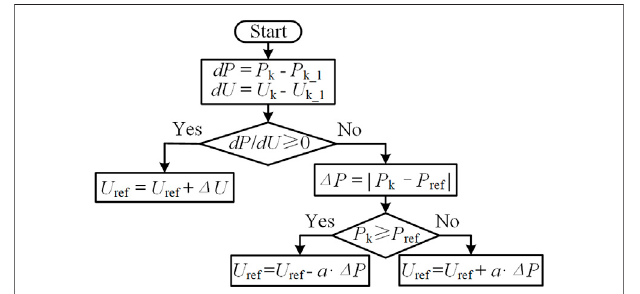
FIGURE 11 | Flowchart of the non-MPPT